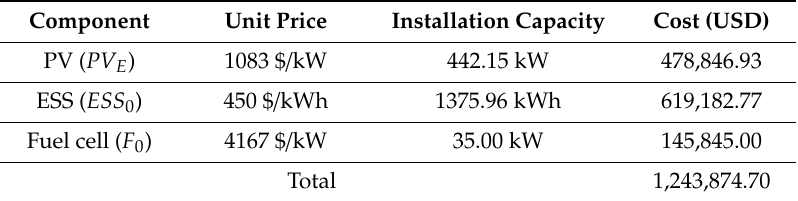
Table 4. Cost of the system designed with a base generation power